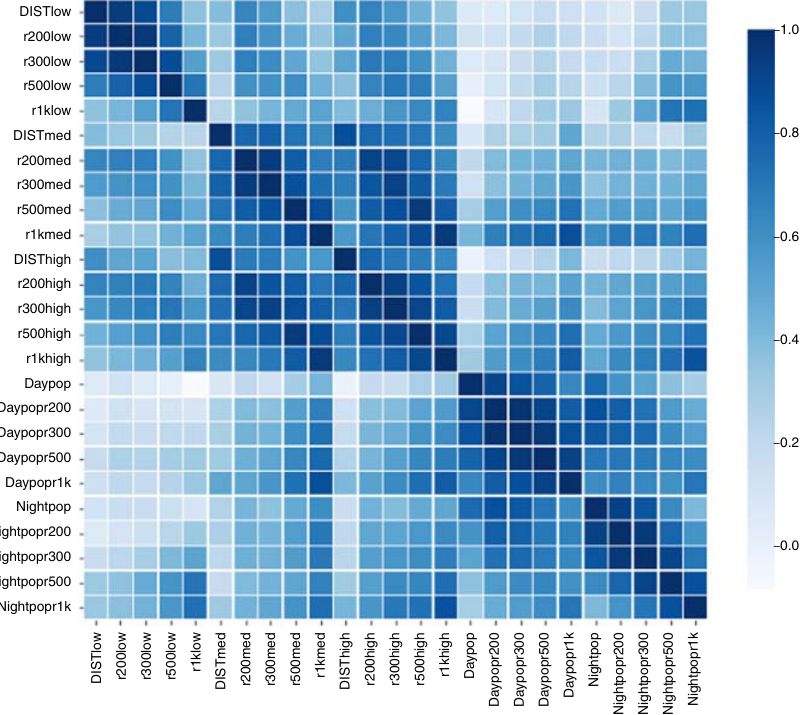
Figure 4. Correlations matrix of catchment area